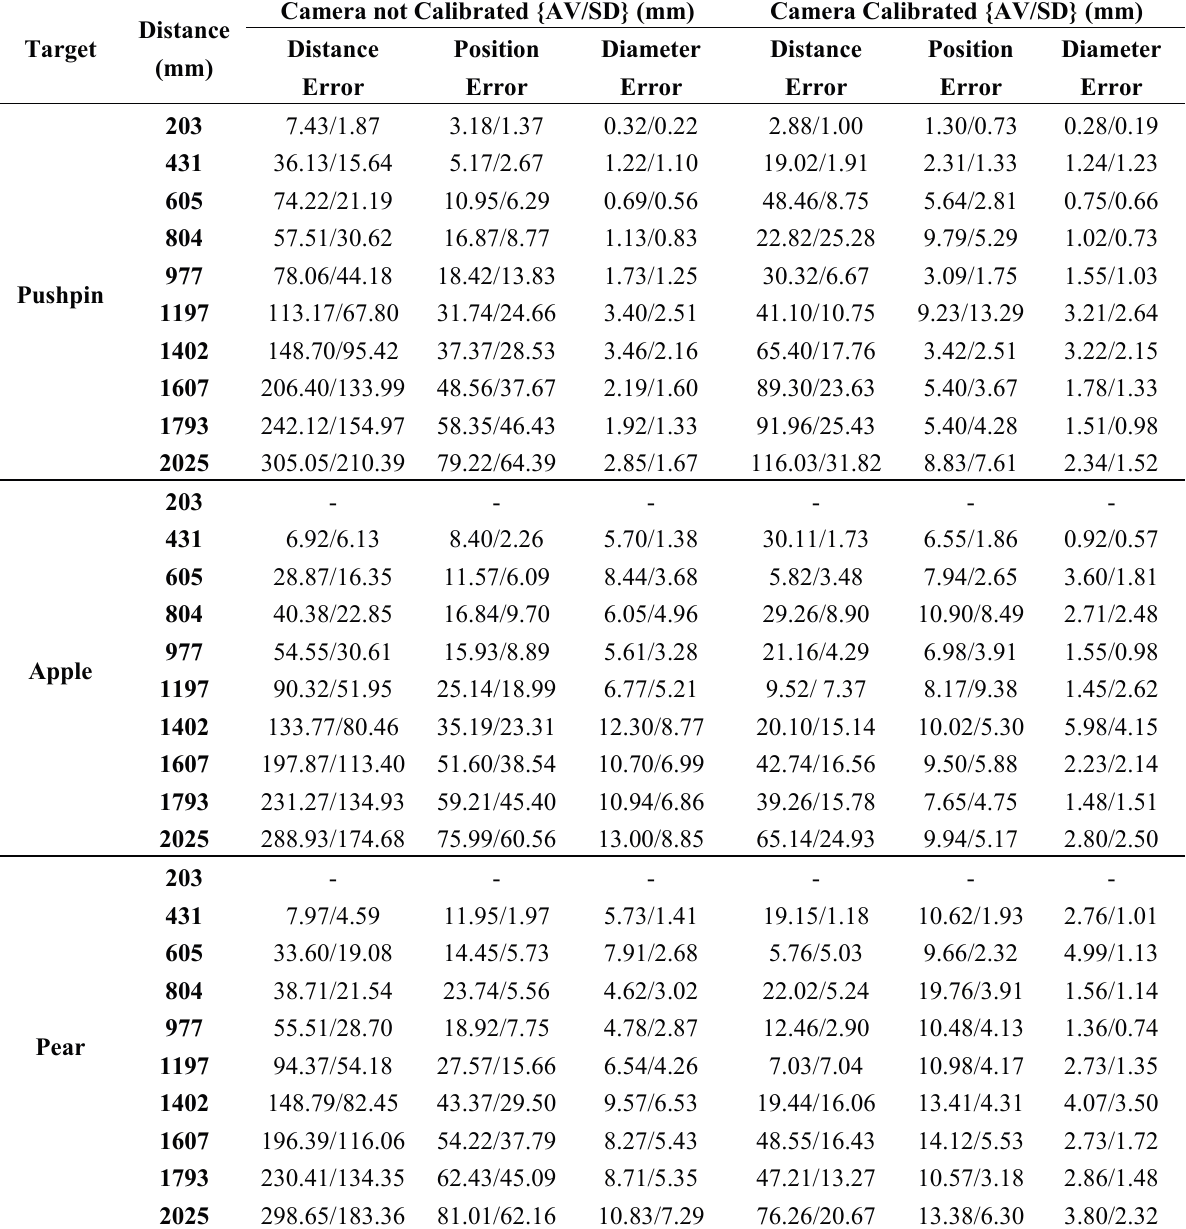
Table 6. Error detection in terms of average (AV) and standard deviation